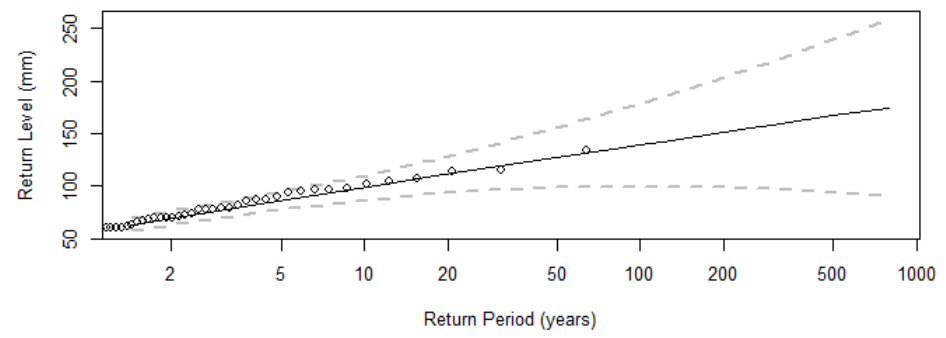
Figure 3. IDF curve of Tolentino for the interval time of 24 h. Dotted line is the confidence interval after 1000 attempts. The black line is the one risulting from the analysis.